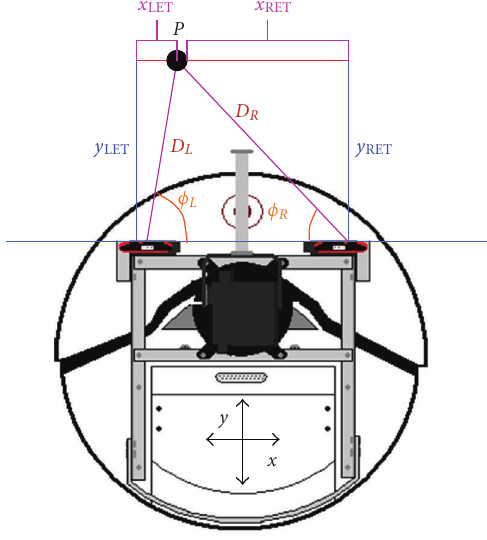
Figure 8: Object polar coordinates.